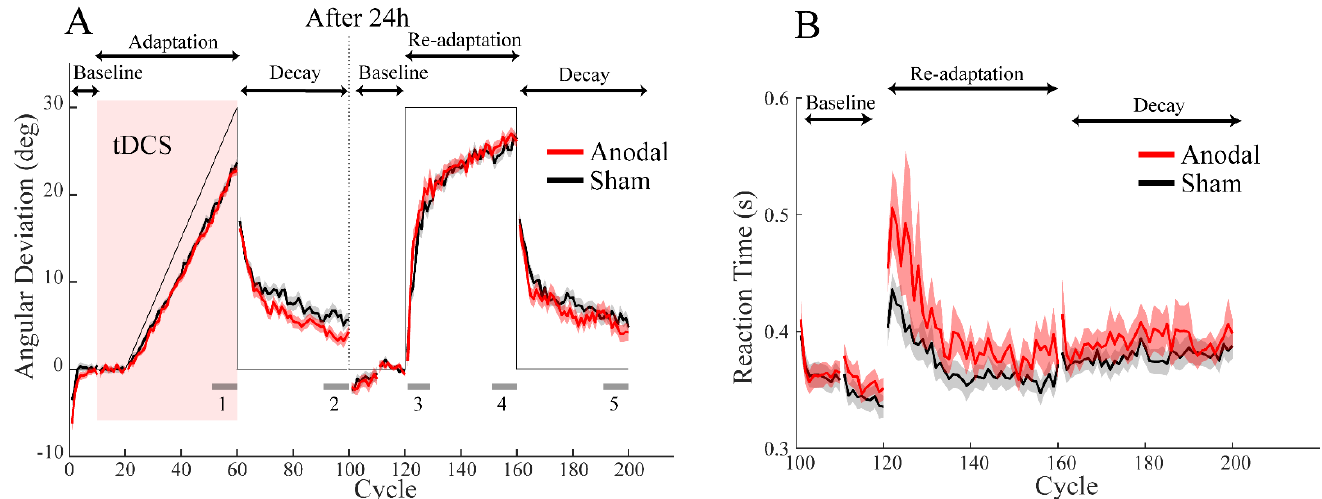
Figure 4. Adaptation performance in Experiment 3. ( A ) The hand deviation angle as a function of trial cycles over two days. The group average (line) and standard error (shade) across participants are shown. The anodal and sham groups are plotted in red and grey, respectively. The experimental phases are marked by the arrows on top of the figure. The red rectangular area denotes the duration of the ctDCS application. The solid black line denotes the visuomotor rotation perturbation. The grey segments on the bottom of the figure show the window for calculating performance measures: 1 and 4 are for the adaptation and re-adaptation extent, respectively; 2 and 5 are for decay residues in the two days; 3 is for the re-adaptation rate on day 2. ( B ) Reaction time as a function of trial cycles for the baseline and the re-adaptation phases on day 2. There is a marked increase in RT when the visuomotor rotation is unexpectedly applied.